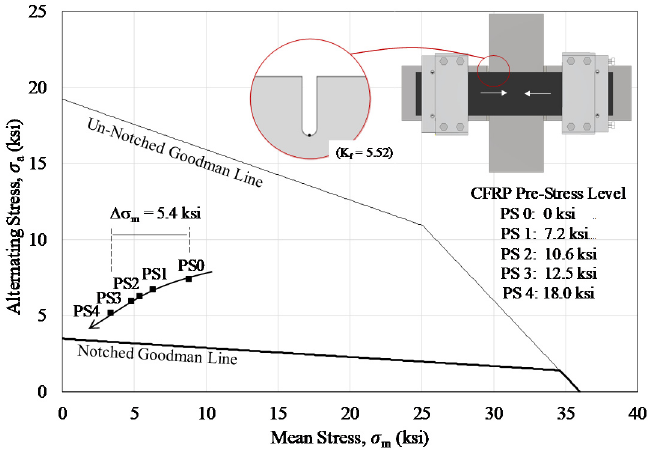
Figure 33. Effect of CFRP pre-stress level on a small-scale component stress state.